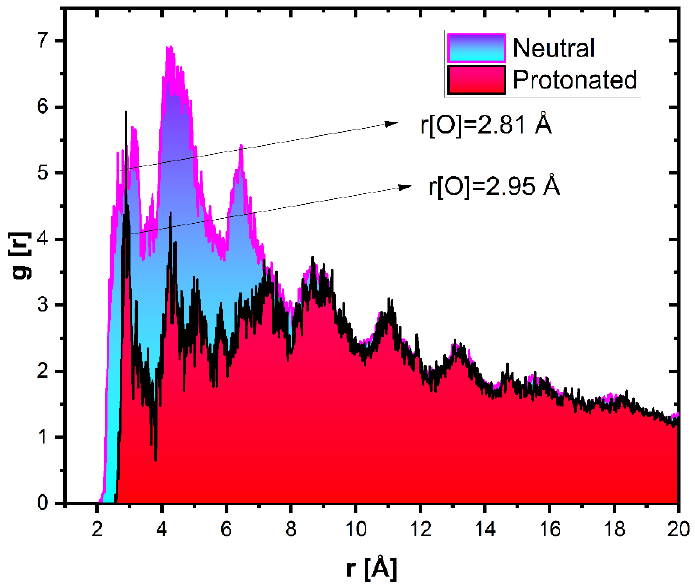
Figure 11. Distribution of the adsorption energy of the inhibitory resin employed in the simulated aggressive environment obtained using MC approaches.